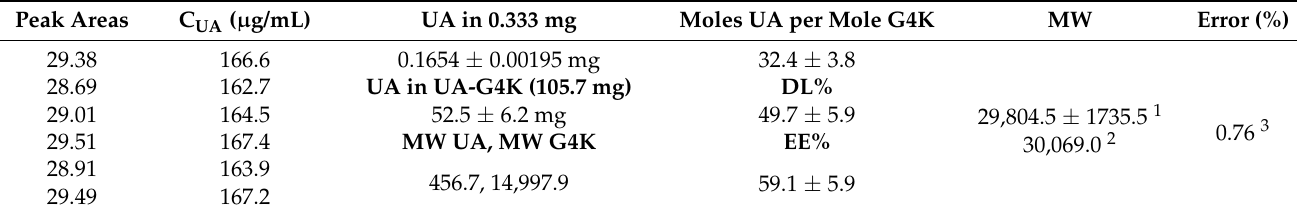
Table 2. Values of peak area obtained for the six aliquots and the related C UA obtained from equation Equation (3), results concerning the concentration of UA in UA-G4K nanoparticles (NPs) and molecular weight (MW) of UA-G4K, as well as the difference expressed as error % between the MW obtained by 1 H NMR and that computed using HPLC results. Peak Areas C UA ( µ g/mL) UA in 0.333